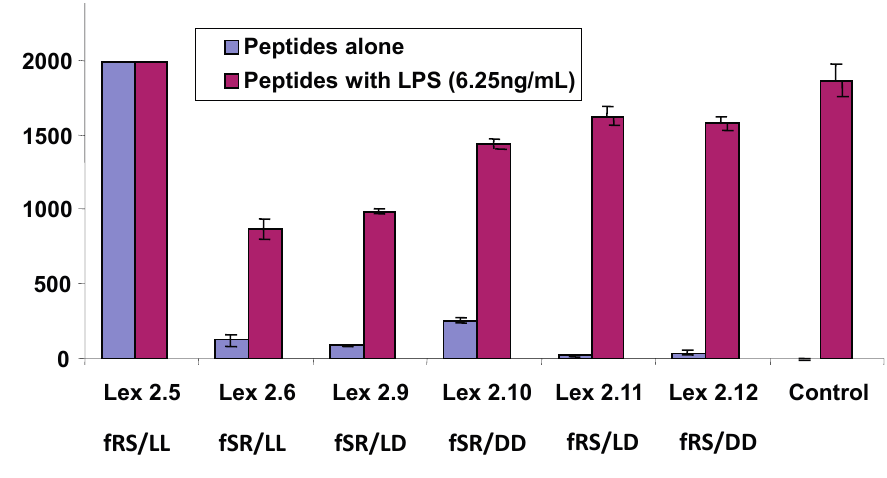
Figure 4. Changes in level of secretion of TNF into the supernatant of LPS-stimulated J774A.1 cells overnight after exposure to cyclic peptides as follows: Lex 2.5 and 2.6 are cyclo( D F-R- L C 10 -S- D F-R- L C 10 -S) and cyclo( D F-S- L C 10 -R- D F-S- L C 10 -R) respectively, Lex 2.9 and 2.10 are cyclo( D F-S- L C 10 -R- D F-S- D C 10 -R) and cyclo( D F-S- D C 10 -R- D F-S- D C 10 -R) respectively, and Lex 2.11 and 2.12 are cyclo( D F-R- L C 10 -S- D F-R- D C 10 -S) and cyclo( D F-R- D C 10 -S- D F-R- D C 10 -S), where C 10 represents an amino acid with an extended C 10 hydrocarbon